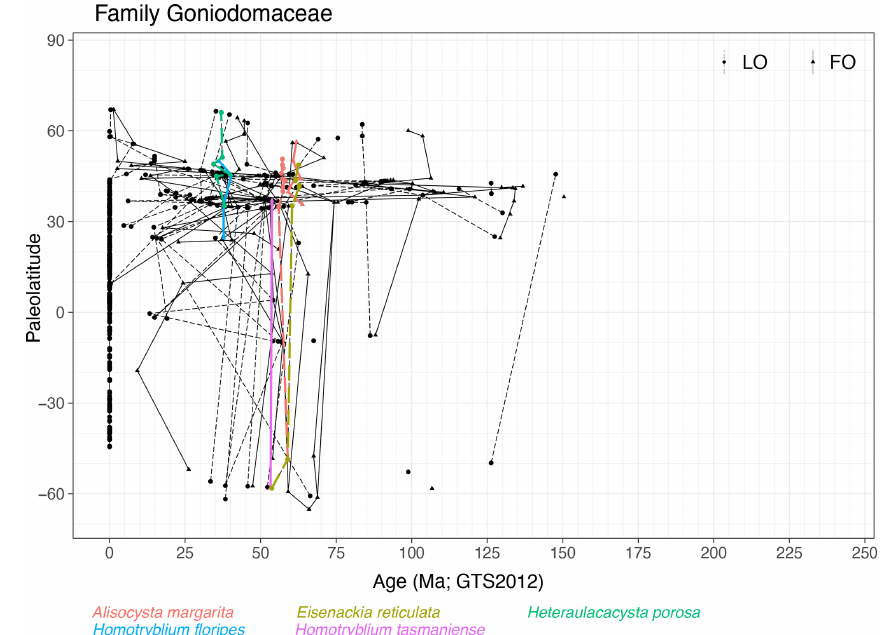
Figure 8. Same as Fig. 5 but for the family Goniodomaceae.